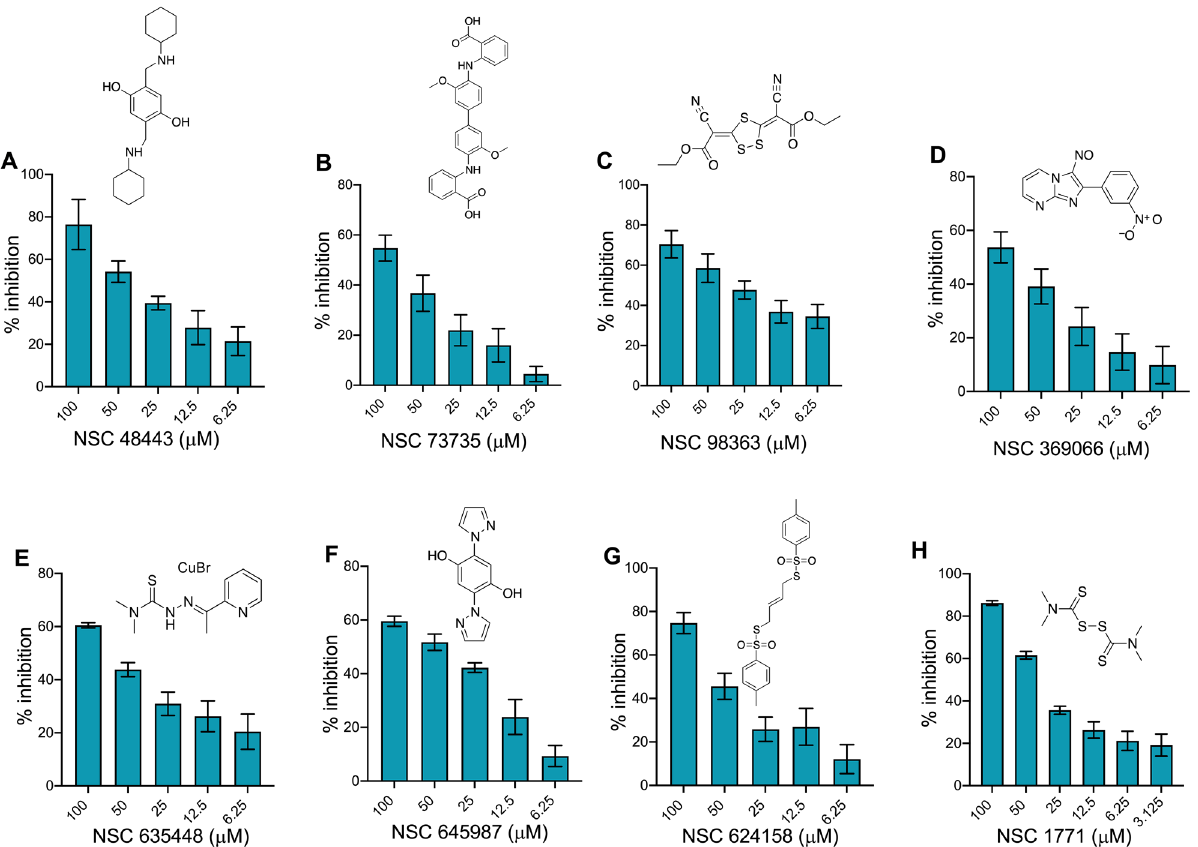
Figure 4. Dose response inhibition of Rv3341 activity by the identified primary hits. MetX enzymatic assays were performed in the presence of different concentrations of primary hits and percentage inhibition was calculated as described in Materials and Methods. The data shown in y-axis represents mean ± S.E. of percentage inhibition obtained from three independent experiments performed in duplicates. The structures of various primary hits are also shown in these